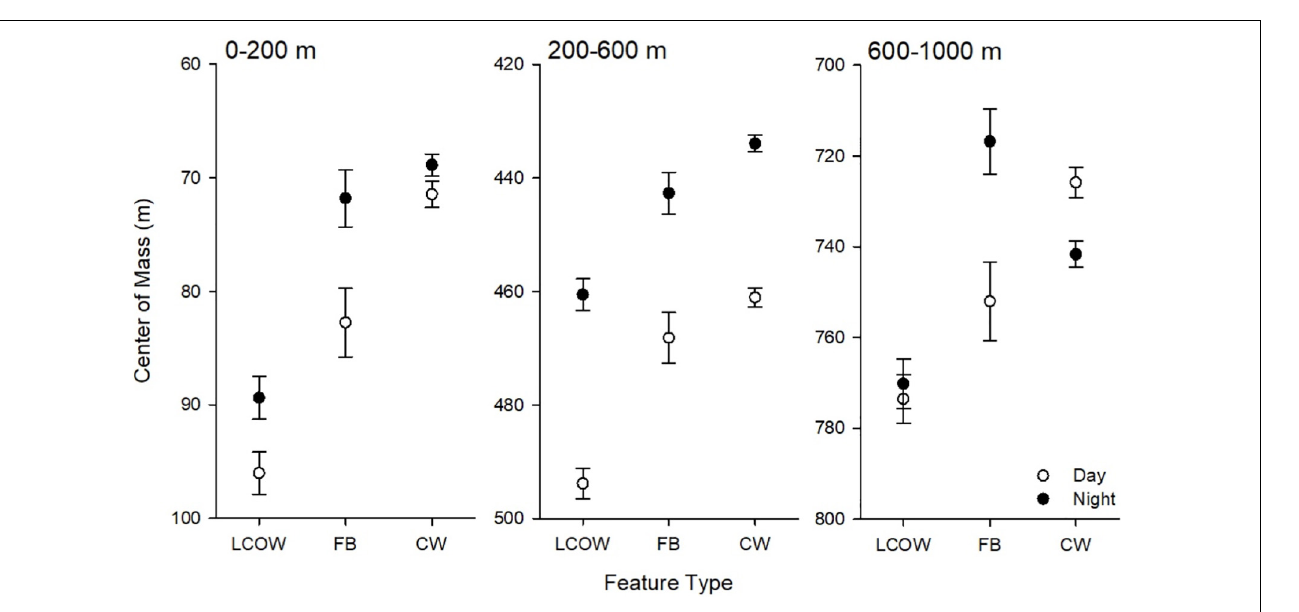
significant interaction between light intensity and LCOW index ( p = 0.02) ( Supplementary Table S2